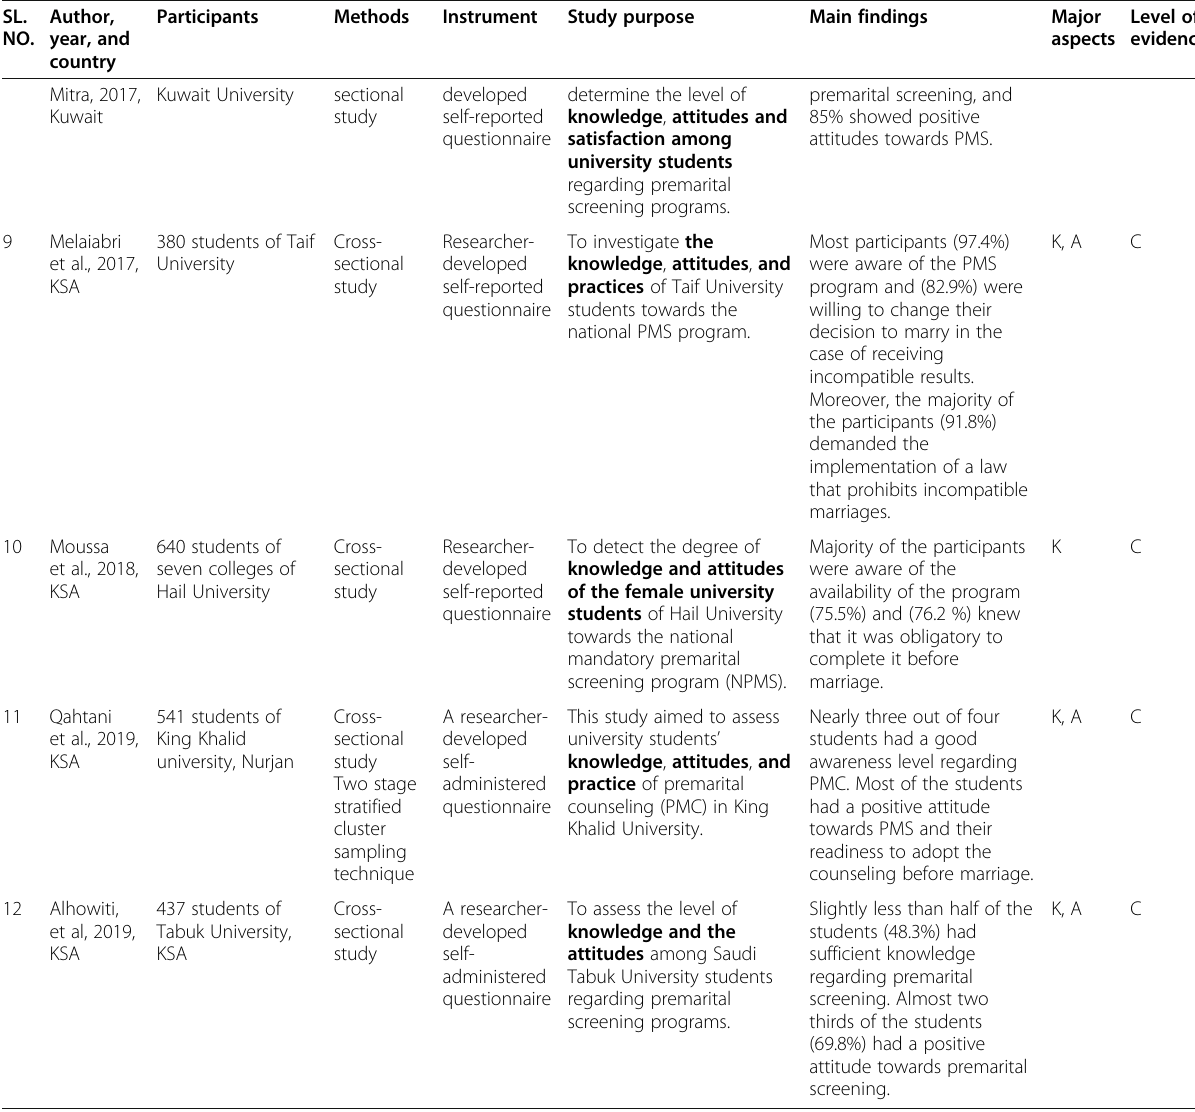
Table 1 Summary of the articles with author, country, year, participants, methods, instruments, study purpose, and main findings (Continued) SL. Author, NO. year, and